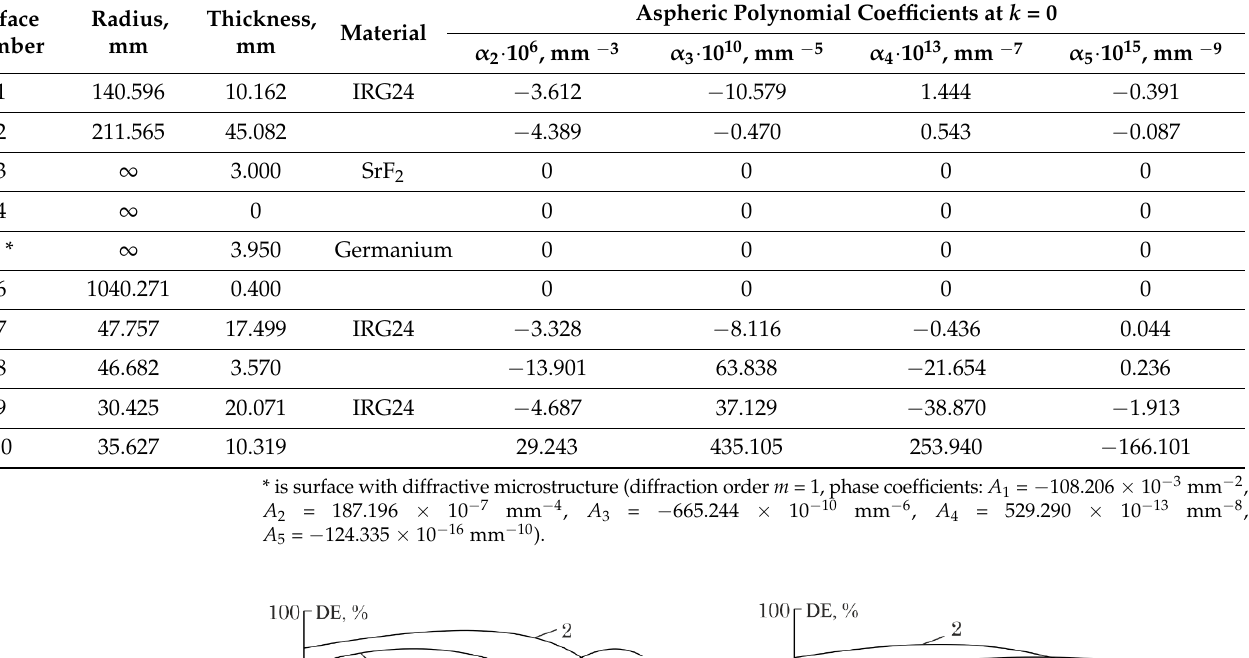
Table 3. Design parameters of the refractive–diffractive version of the ultra-high-aperture athermal dual-range IR objective.